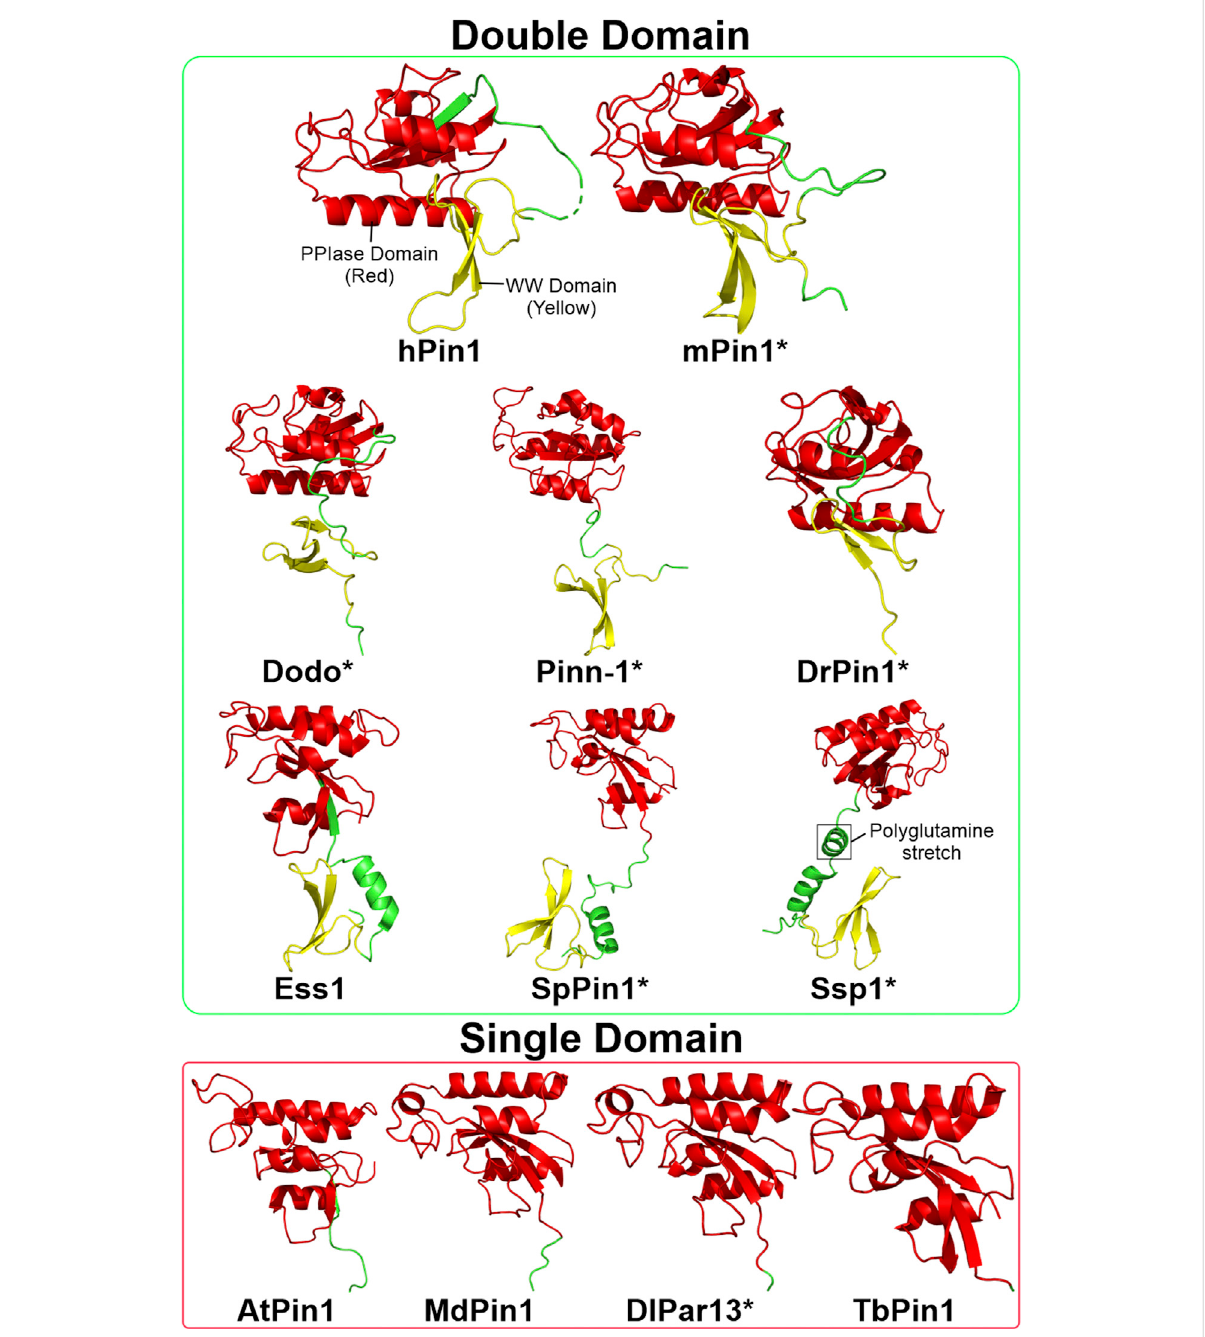
FIGURE 3 Structures of Pin1 orthologs across various species. The green box contains Pin1 orthologs with both WW and PPIase domains; the red box contains Pin1 orthologs with only the PPIase domain. Asterisks indicate that the protein structure is predicted using AlphaFold (Jumper et al., 2021). The linking region between the WW and PPIase domains of Ssp1 contains a conserved polyglutamine stretch. Red: PPIase domain; green: linking region; yellow: WW domain. Structures are obtained from UniProtKB and processed using PyMOL 2.5 software. hPin1: Human Pin1; mPin1: MousePin1;DrPin1: D.rerio Pin1;Pinn-1: C.elegans Pin1;Dodo: D.melanogaster Pin1;Ess1: S.cerevisiae Pin1;SpPin1: S.pombe Pin1;Ssp1: N.crassa Pin1; LjPar1: L. japonicus Pin1; MdPin1: Malus domestica Pin1; Pin1At: A. thaliana Pin1; DlPar13: D. lanata Pin1; TcPin1: T. cruzi Pin1; TbPin1: T. brucei